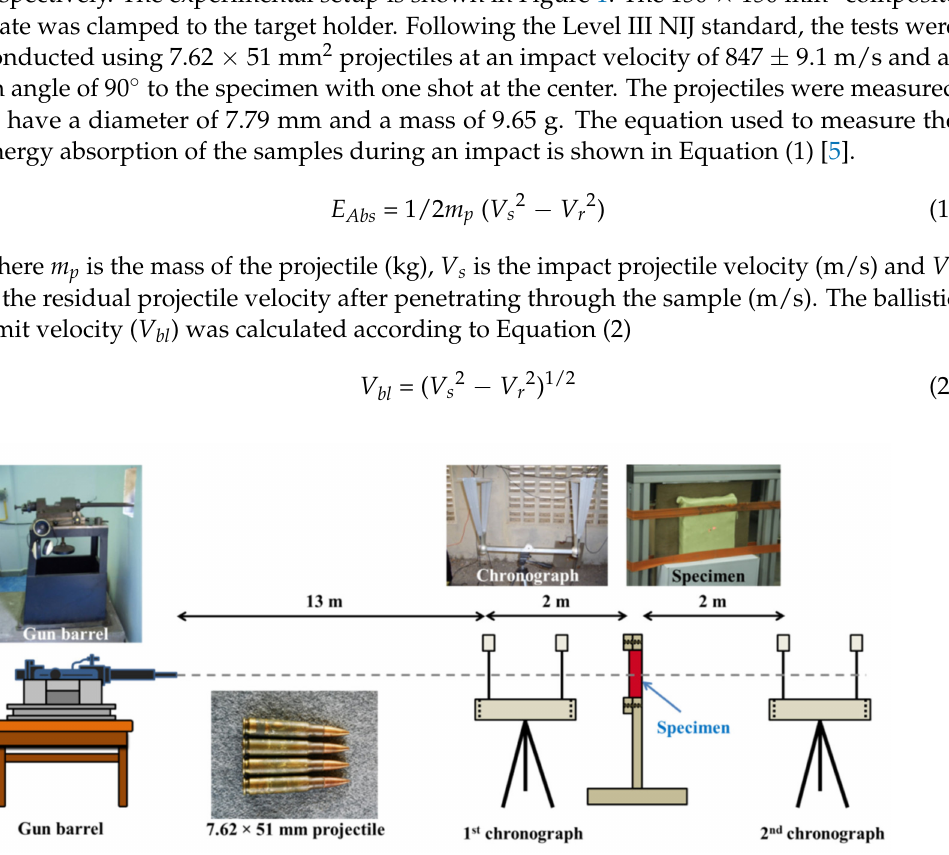
Figure 1. Illustration of the experimental setup used for the high-velocity impact